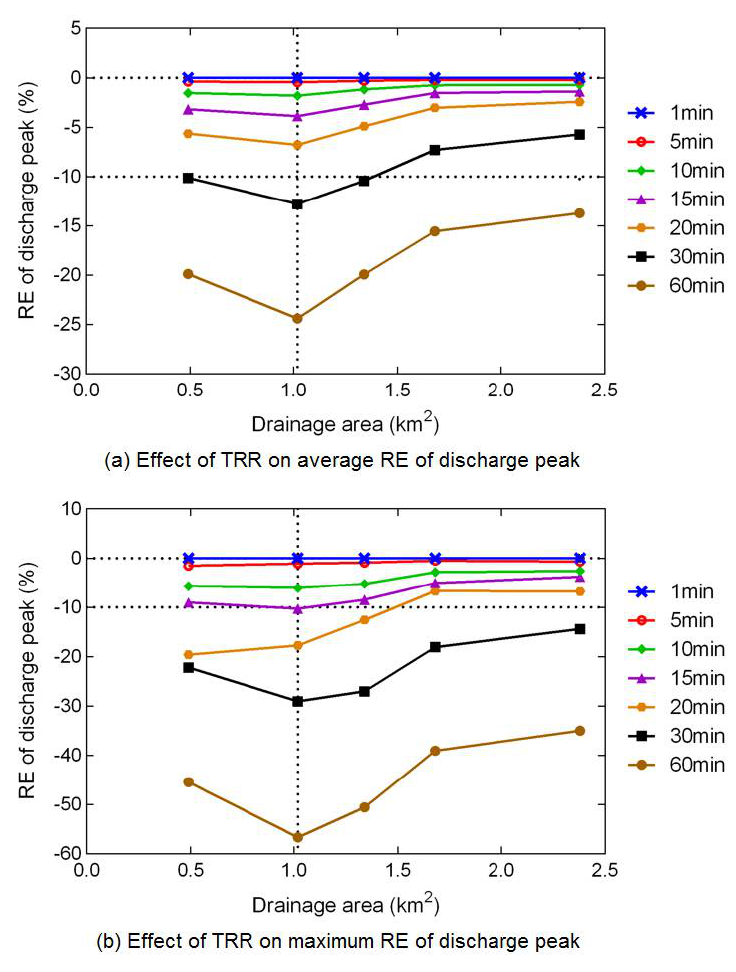
Figure 8. Effect of TRR at subcatchment scale considering the drainage area, for all the 30 events. ( a ) shows the average effect, and ( b ) shows the largest effect.